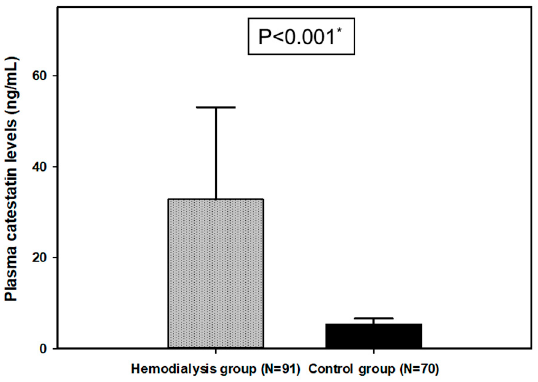
Figure 2. Plasma catestatin (CST) levels in hemodialysis (N = 91) and control group (N = 70) participants. *, t -test for independent variables.